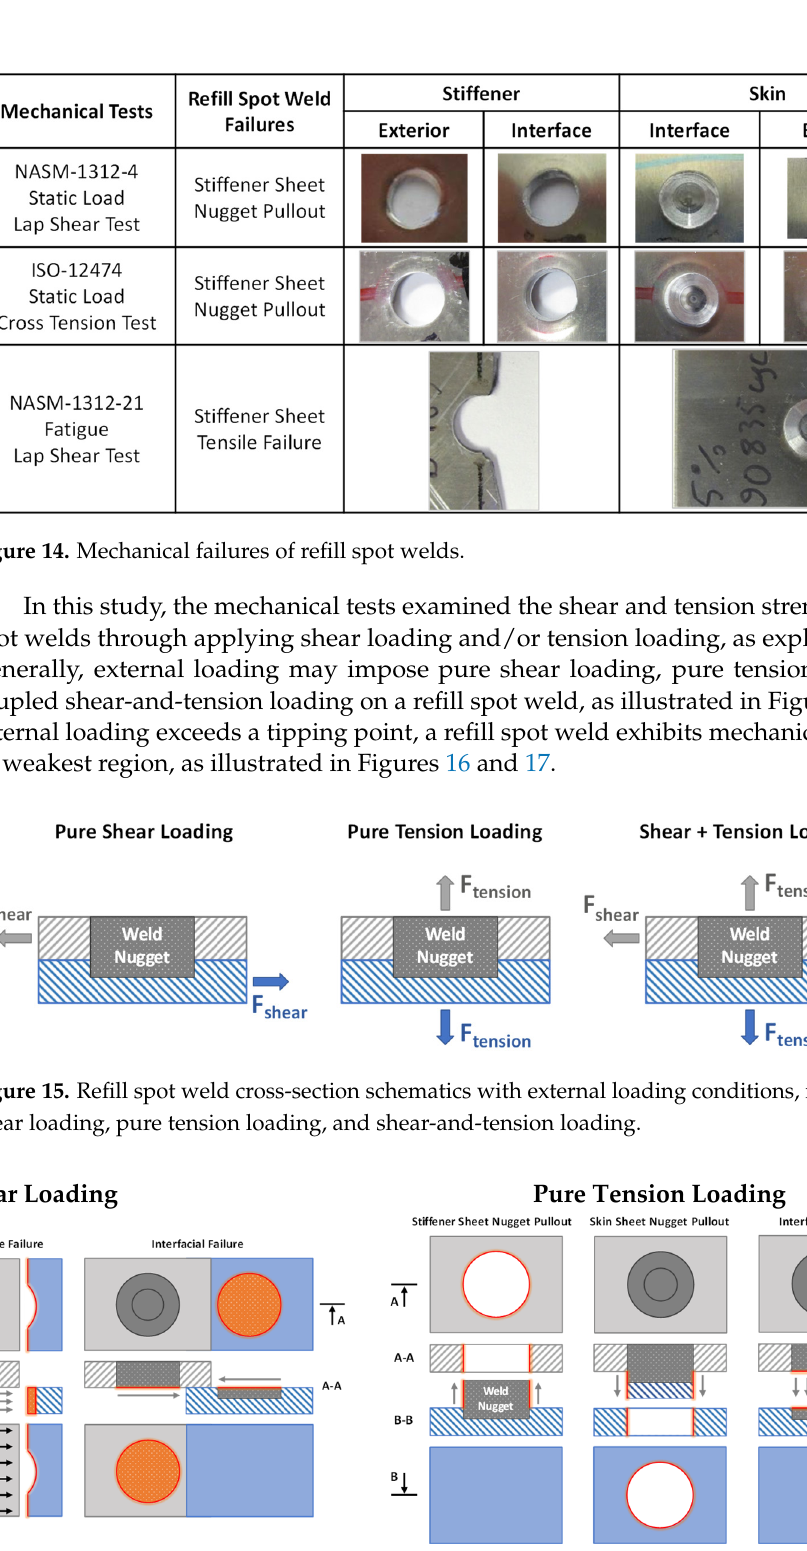
( b ) Figure 17. Schematics of refill spot weld failures caused by coupled shear-and-tension loading: ( a ) parent metal tensile failures and ( b ) nugget pullout failures and an interfacial failure. The graphics of each failure include the top view, the cross-section view, and the bottom view. The failure surfaces are highlighted in orange and red. Under pure shear loading, a refill spot weld may demonstrate a stiffener sheet tensile failure, a skin sheet tensile failure, or an interfacial shear failure, as illustrated in Figure 16a. The failure mechanism chooses the weakest region to fail first. A refill spot weld demonstrates a stiffener or skin sheet tensile failure if the stiffener or skin sheet is the weakest region. Pure shear loading on the refill spot weld imposes pure tension loading on the parent sheet metals. Therefore, the parent metals may exhibit tensile failures under pure shear loading. In addition, a refill spot weld demonstrates an interfacial shear failure, as illustrated in Figure 16a, if the interfacial bond is the weakest region. Factors that make a particular region the weakest region include any possible defects, the properties of the parent metals, and the properties of the weld regions. The properties can be geometric, metallurgical, and/or mechanical. Under pure tension loading, a refill spot weld may exhibit a stiffener sheet nugget pullout, a skin sheet nugget pullout, or an interfacial tension failure, as illustrated in Fig- ure 16b. The failure mechanism chooses the weakest region to fail first. A refill spot weld demonstrates a nugget pullout if the TMAZ or HAZ in the stiffener or skin sheet is the weakest region. A nugget pullout is a shear failure within the TMAZ or HAZ. Pure tension loading on the refill spot weld imposes pure shear loading on the parent sheet metals. In